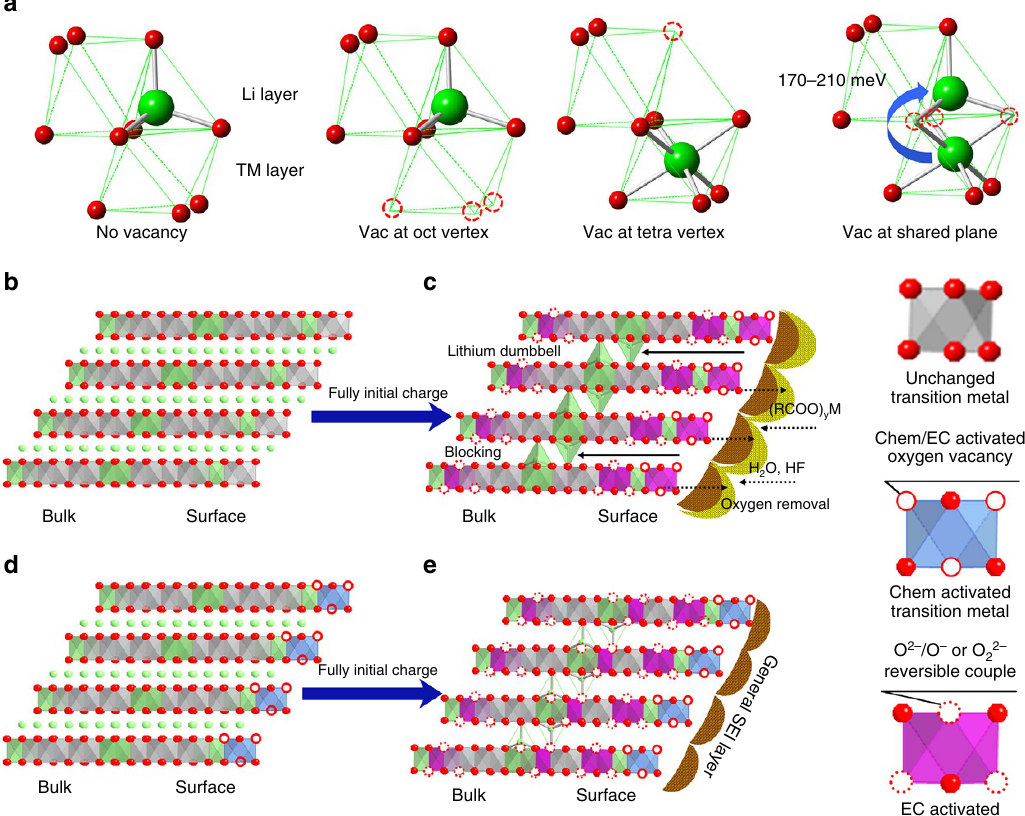
Figure 6 | Reaction mechanisms during charging and discharging. ( a ) Calculated site stability and activation barrier under conditions of no vacancy, vacancy at octahedron (Oct) vertex, vacancy (Vac) at tetrahedron (Tetra) vertex and vacancy (Vac) at shared plane. ( b , c ). The pristine LR-NCM before charging and after full initial charge. ( d , e ) The GSIR LR-NCM before charging and after full initial charge. Green, Li; red, O. The fundamental contribution of the novel surface modification is the uniform creation of lithium and oxygen vacancies on the surface of particles before electrochemical cycling. Consequently, more Mn 4 þ /Mn 3 þ redox couples in Li 2 MnO 3 component are pre-activated; less oxygen gas is released from the material and less oxygen vacancies are created in the bulk during the charging process; limited electrode/electrolyte corrosion and bulk material structure transformation are formed in the battery